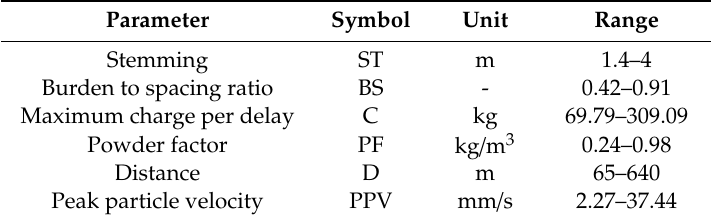
Table 2. Range, unit and symbol of the measured parameters in the